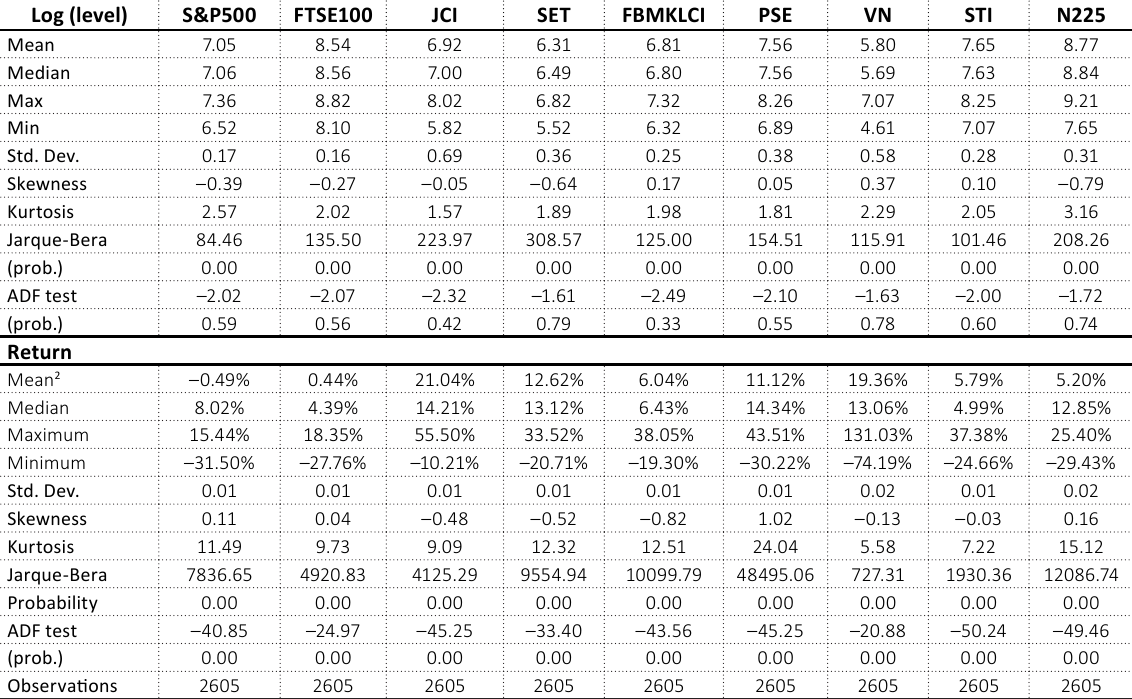
Table 1. Stock market index descriptive